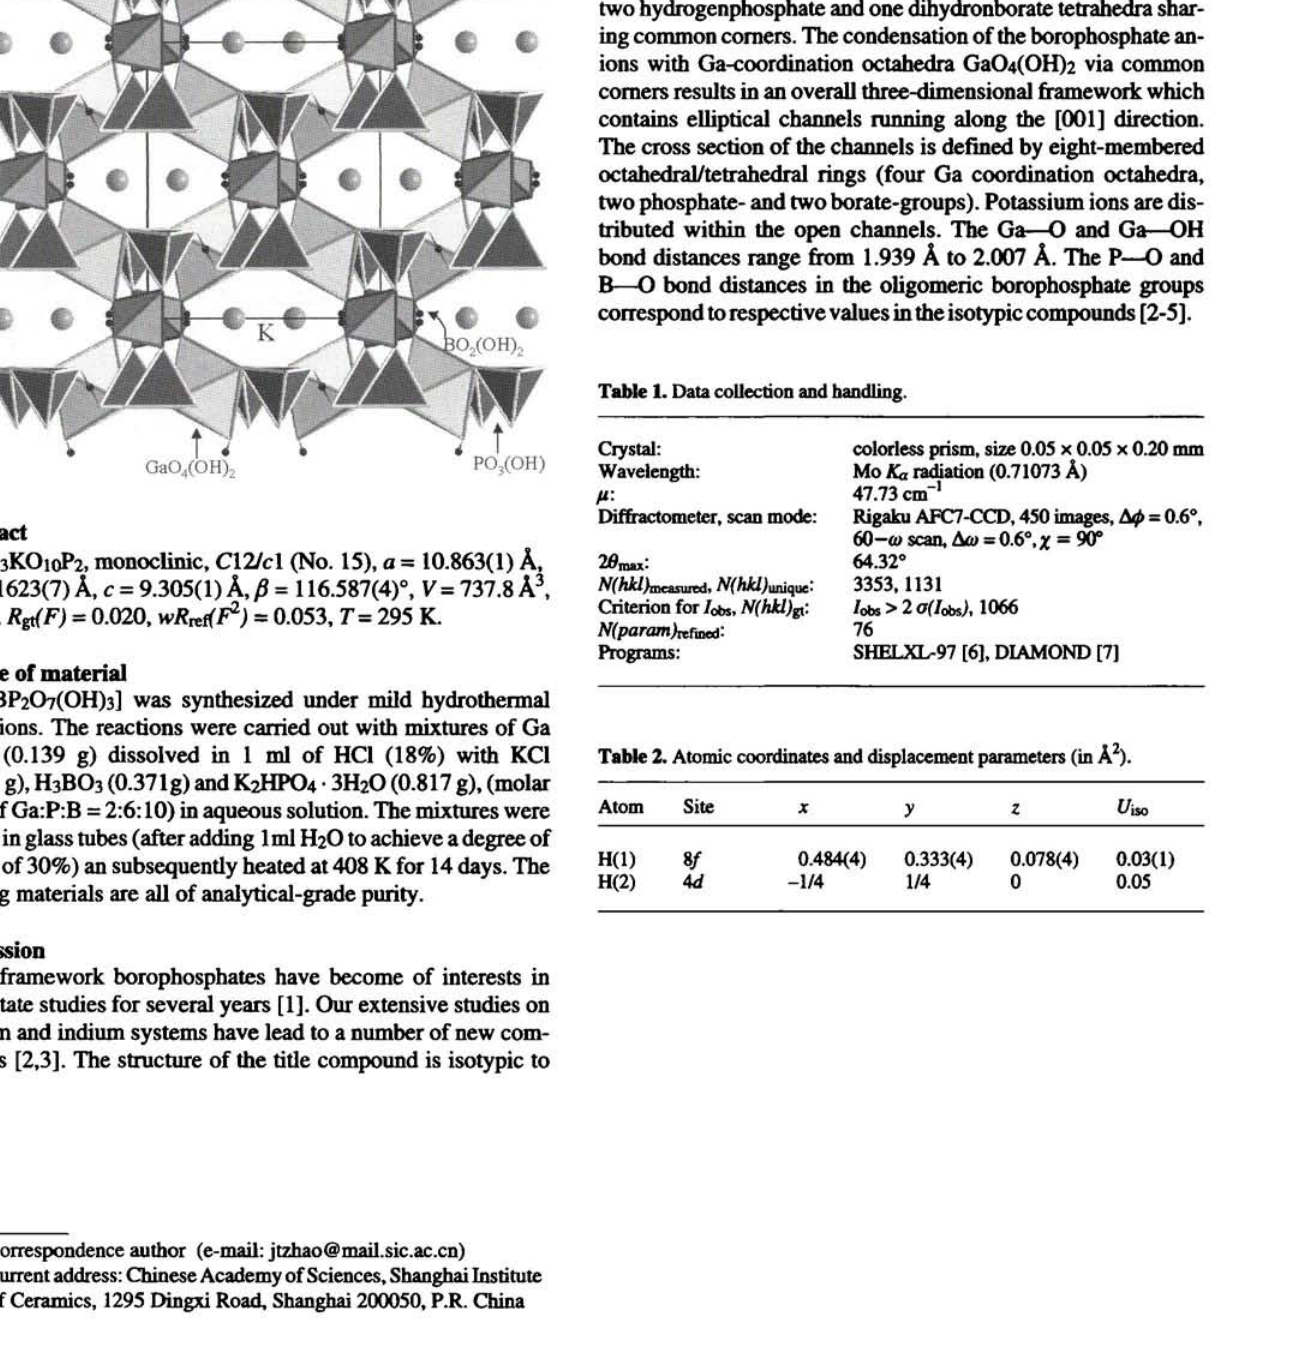
Table 2. Atomic coordinates and displacement parameters (in Â 2